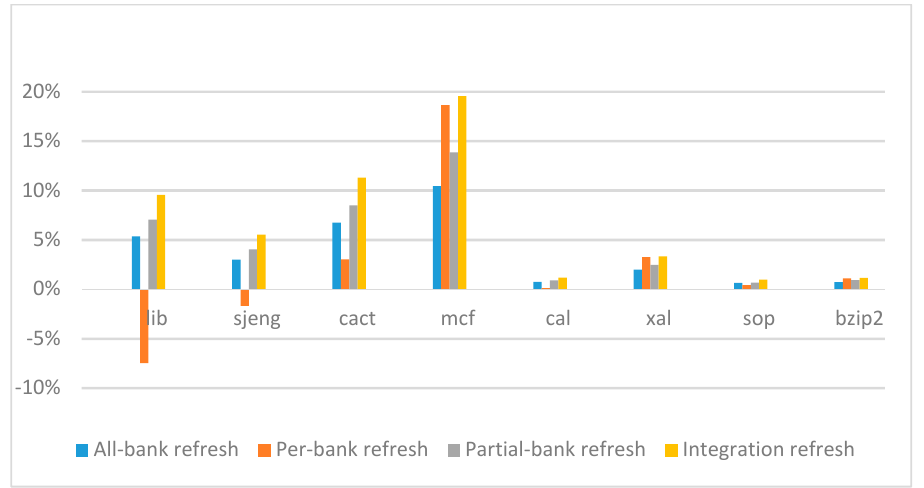
Figure 14. Instructions-per-clock (IPC) improvement normalized to 1x granularity baseline (tRFC = 530 ns, weak row = 1%).